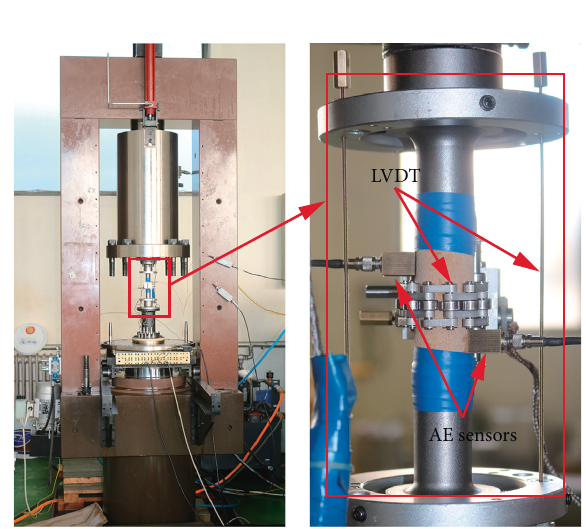
Figure 1: Uniaxial compression test setup.